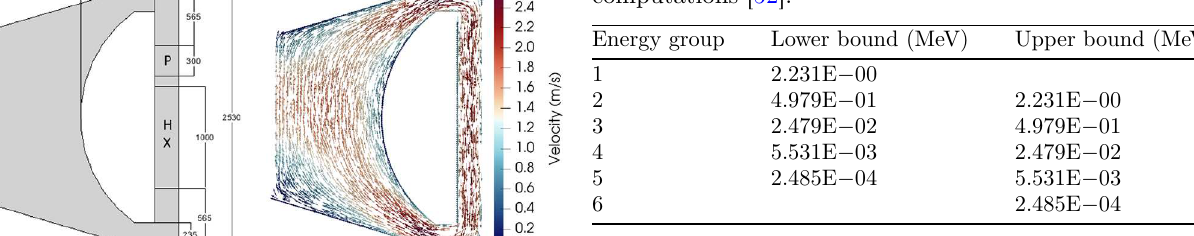
Table 1. The energy group structure used for the computations [52].